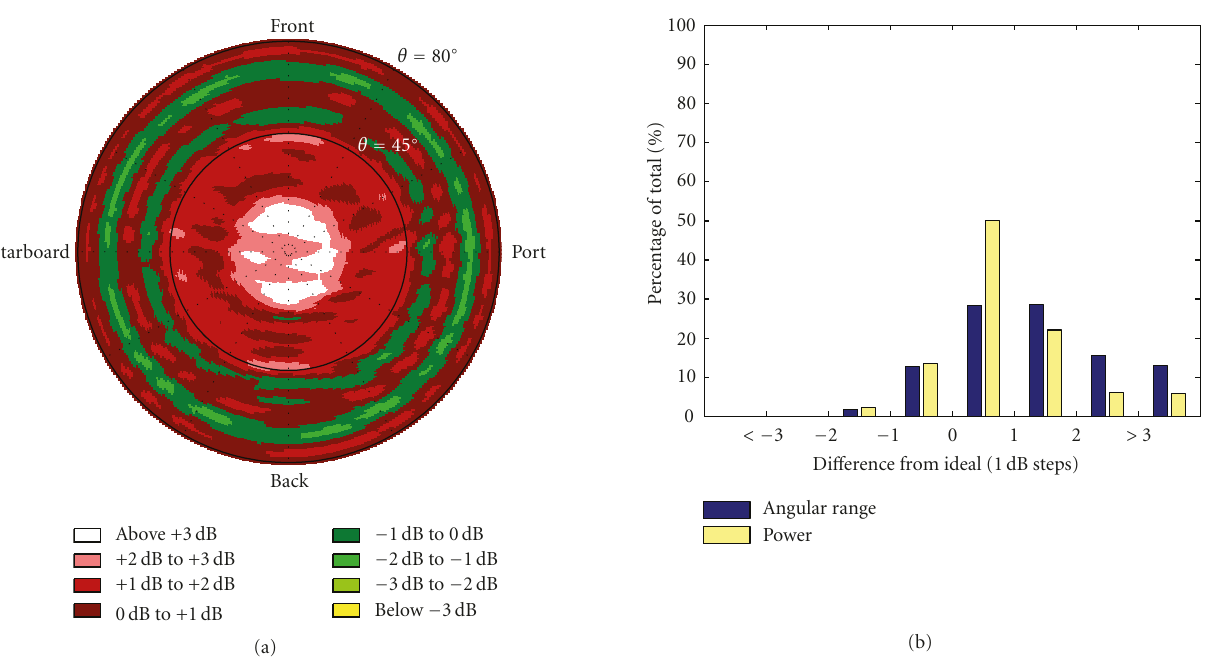
Figure 15: Assessment of 5-turn helical antenna radiation pattern on the gondola normalised to θ = 80 ◦ minima; (a) flattened hemisphere plot of gain comparison to ideal radiation pattern shape, (b) radiation pattern power distribution in relation to ideal radiation pattern shape, from